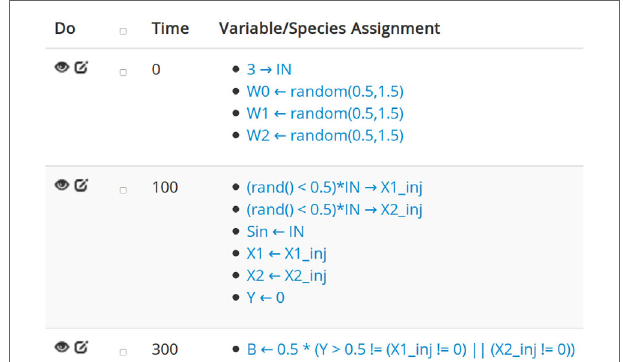
FIGURe 1 | details of a CoeL interaction series showing its programing capabilities . Left arrows denote the setting of species concentrations and right arrows indicate assignments of user-defined variables. The interaction at time 100 does the following (note that at time 0, the variable IN is set to 3): first, the variables X 1_ inj and X 2_ inj are randomly set to 0 or 3 with equal probability. The concentration of Sin is set to 3. Then, both the concentrations of X 1 and X 2 are set to their respective injection variables. Finally, Y is flushed from the system. The bottommost interaction injects species B at concentration 0.5 if the output species Y does not match AND of the original input concentrations X 1_ inj and X 2_ inj .